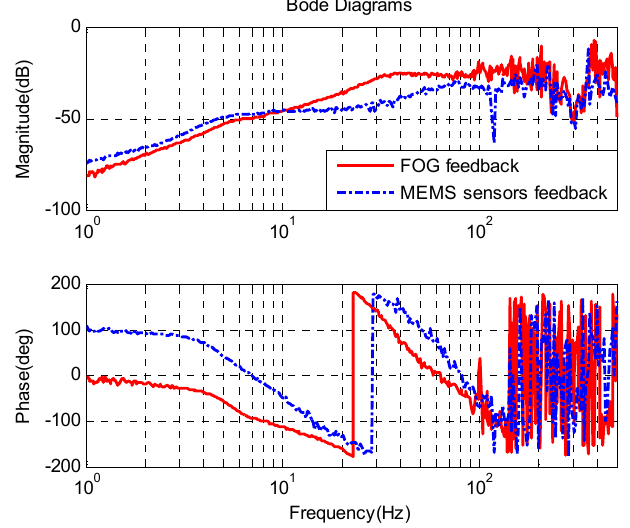
Figure 14. Disturbance suppression characteristics. Table 2. Comparison between disturbance suppressions of two kinds of FSM control systems. Frequency with FOG